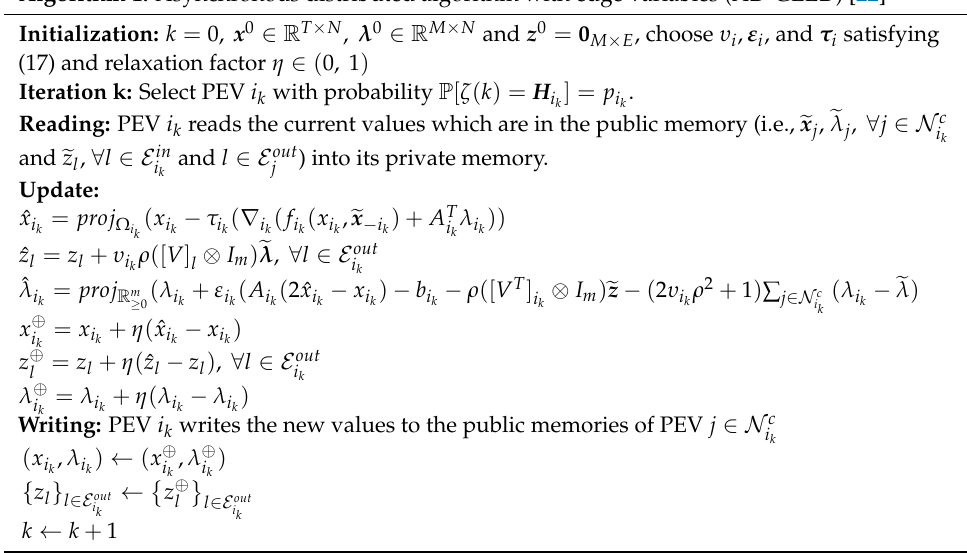
Algorithm 1. Asynchronous distributed algorithm with edge variables (AD-GEED)